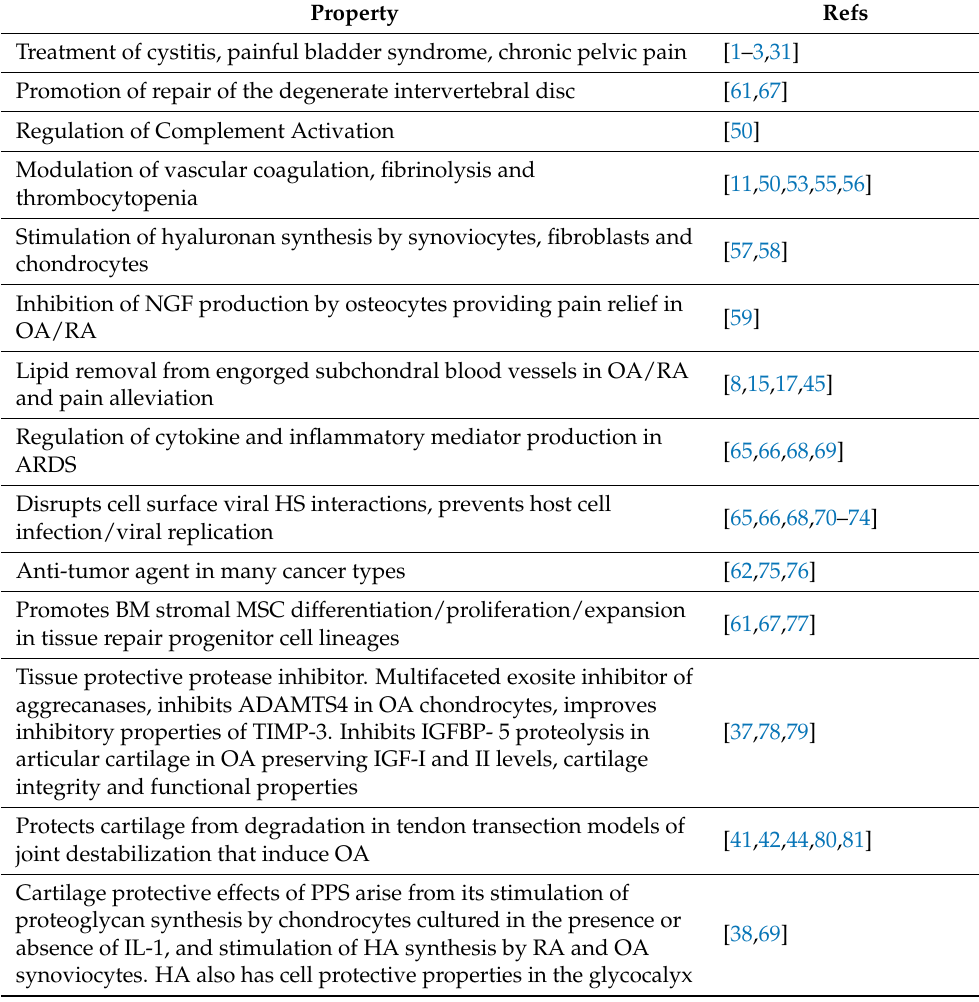
Table 1. Illustrative Examples of The Cell and Tissue Protective Properties of PPS.